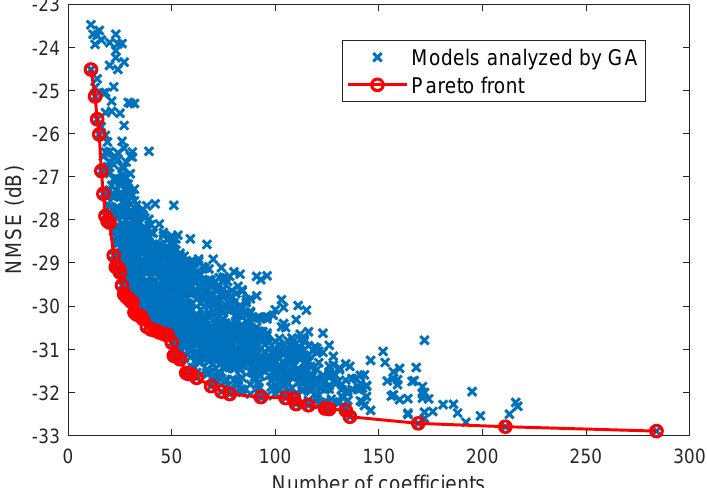
Figure 7. NMSE versus number of coefficients for the models analyzed in the execution of the GA and their Pareto